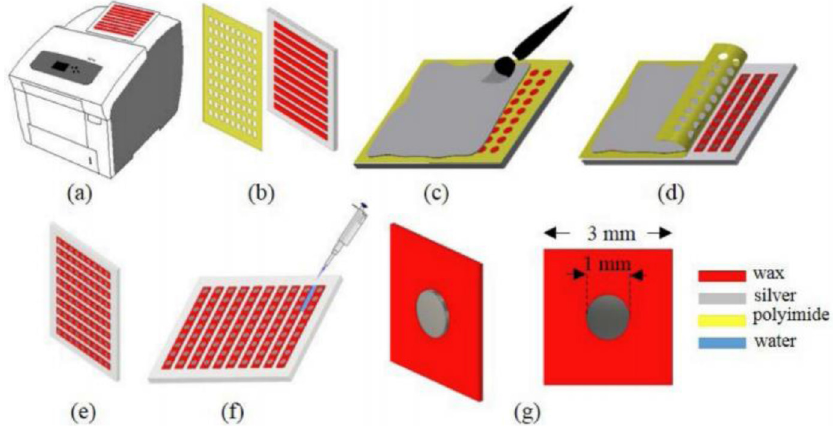
Fig. 6. Schematic fi gures showing the Wax printer fabrication process [86]. Reproduced with permission from A. Sadeqi, H.R. Nejad, S. Sonkusale, Opt. Express 25 , 16092 (2017). © The Optical Society. (This fi gure is subject to copyright protection and is not covered Table 1. Comparison of the micro- and nano- fabrication methods. Method